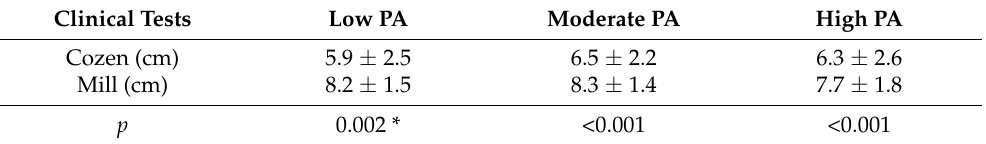
Table 2. Mean, standard deviation and comparisons of clinical inter-tests of pain symptoms and phys- ical activity levels (PA): low, moderate, and high in adults’ elbow diagnosed with lateral